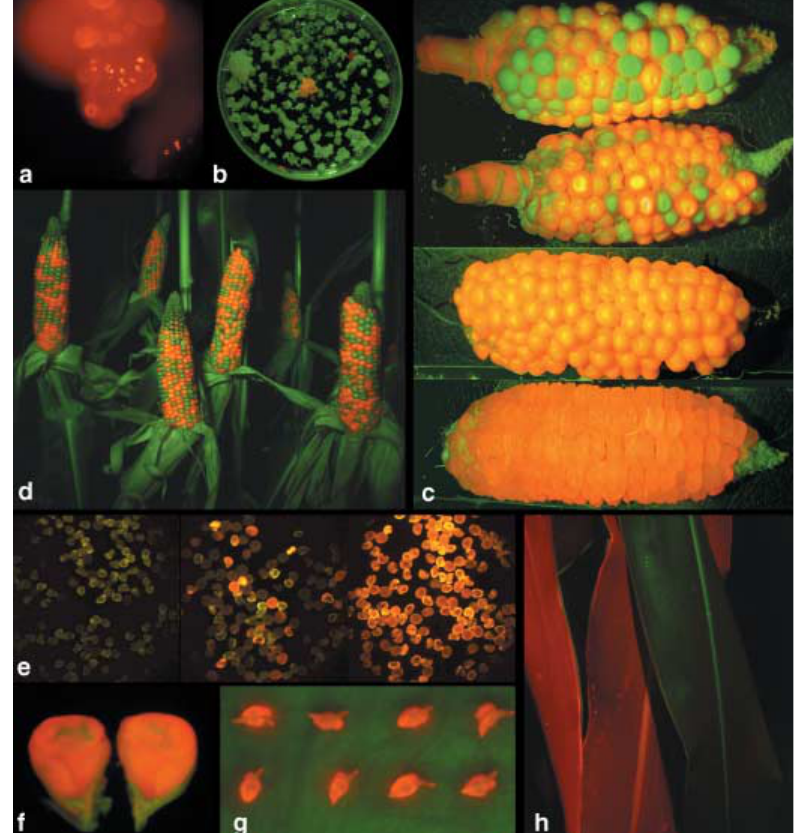
selectable bar gene, and the light chain (LC) gene in tandem with the gene for the screenable marker DsRed (Figure 1).